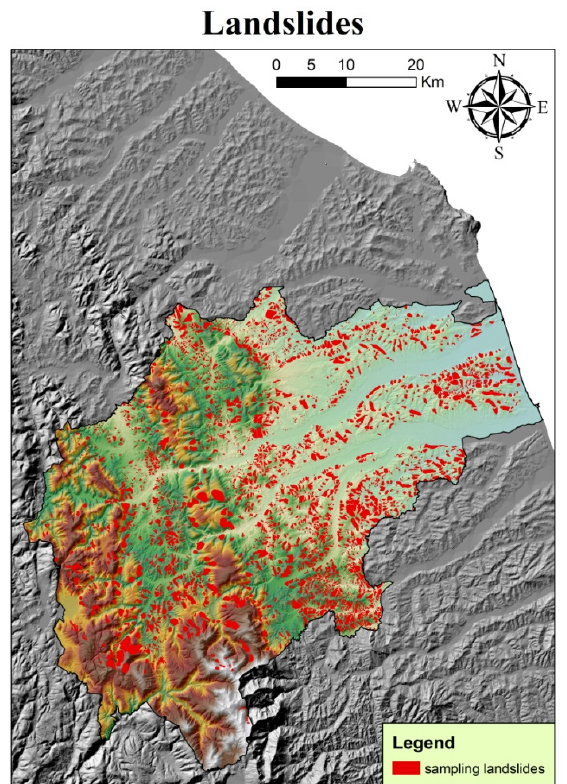
Figure 2. Map of sampled landslides.